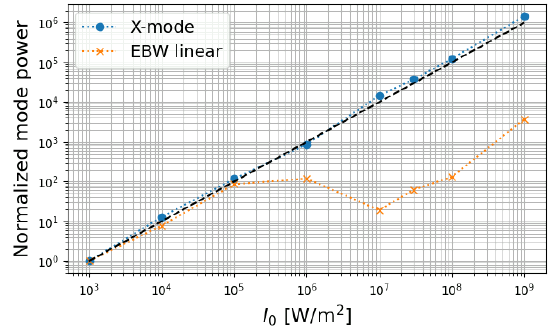
Figure 4: Scaling of X- and linearly converted EBW power with pump intensity. The points are normalized to that of the lowest intensity simulation and the dashed black line is a linear reference